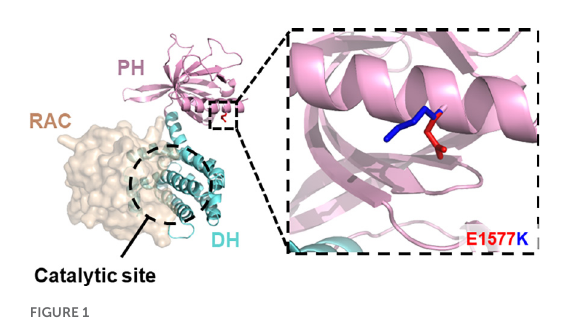
FIGURE1 E1577 lies distal to the catalytic GEF site. Homology model of the Kalirin DH- (cyan) PH (pink) in complex with Rac11 (tan, surface) reveals the surface exposed position of glutamate 1577 (inset, blue) and the predicted position of lysine (red) mutant at this site. Note, E1577 lies distal to the catalytic site suggesting indirect modulation of Kalirin GEF